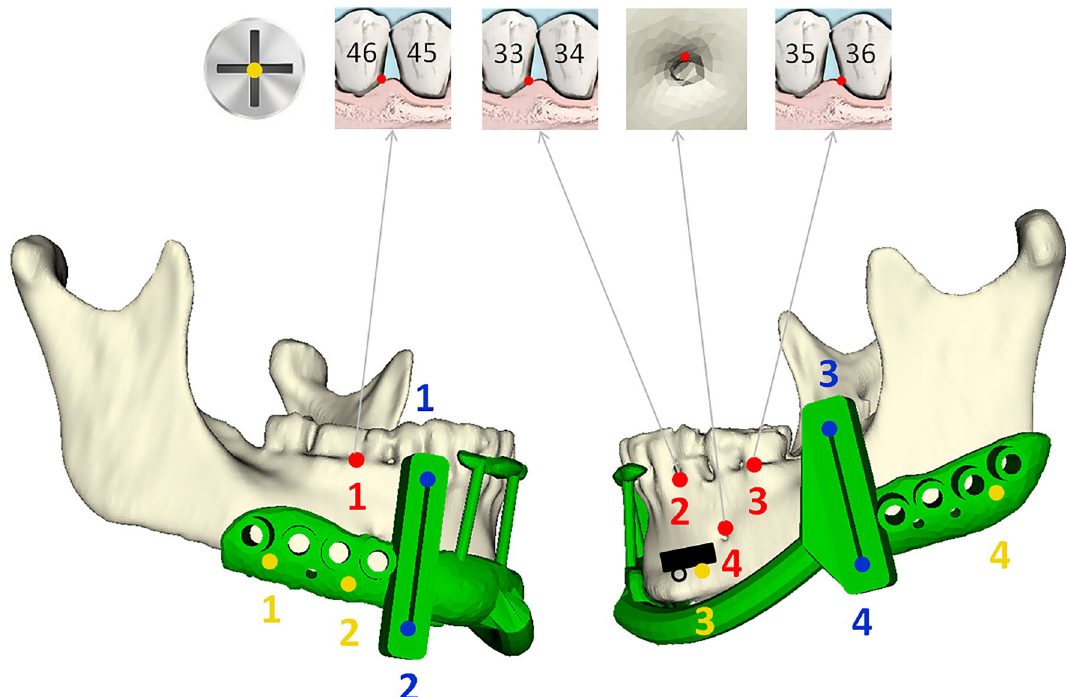
Figure 3. Schematic model of a mandible with the cutting guide (green). The sensor housing module (black) is fixated on the part of the mandible that will be resected. The yellow landmarks are used for fiducial registration. The anatomical landmarks (red) are located on teeth and mental foramen. The landmarks at the cutting guide (blue) are located in the upper and lower ends of the sawing slots. Dental numbering according to the FDI World Dental Federation (ISO